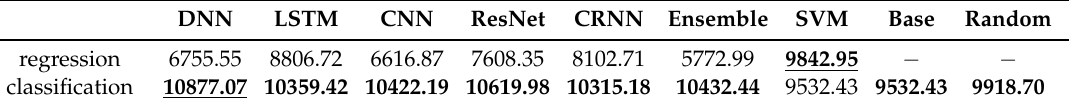
Table 13. Results of a profitability analysis. m = 20 was used for regression models and m = 50 for classification models. The log values of the major features, the sequential partitioning, and the first value-based normalization were used. For every model, the initial budget was 10,000 USD and the final value of investment is shown in the